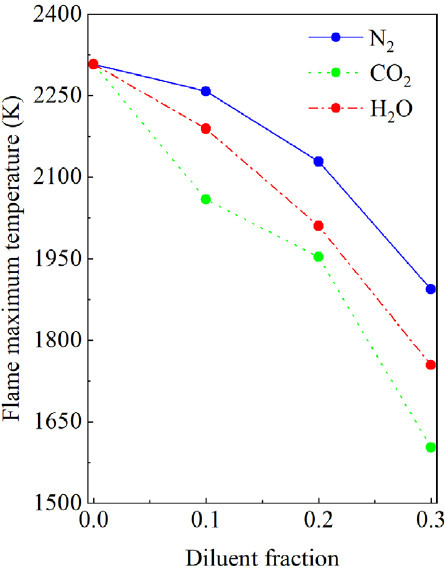
Figure 4. Variation in the maximum temperature with the diluent fractions. OH radicals can be used to identify the regions with concentrated exothermic reac- tivity and to characterize the resulting flame structure. Figure 6 shows the OH radical concentration for the F, FN, FC, and FH flames at different diluent fractions, where a0, b0, and c0 are the OH radical concentrations for the F flames; a1, a2, and a3 are the OH radical concentrations for the FN1, FN2, and FN3 flames; b1, b2, and b3 are the OH radical concentrations for the FC1, FC2 and FC3 flames; and c1, c2, and c3 are the OH radical concentrations for the FH1, FH2 and FH3 flames,